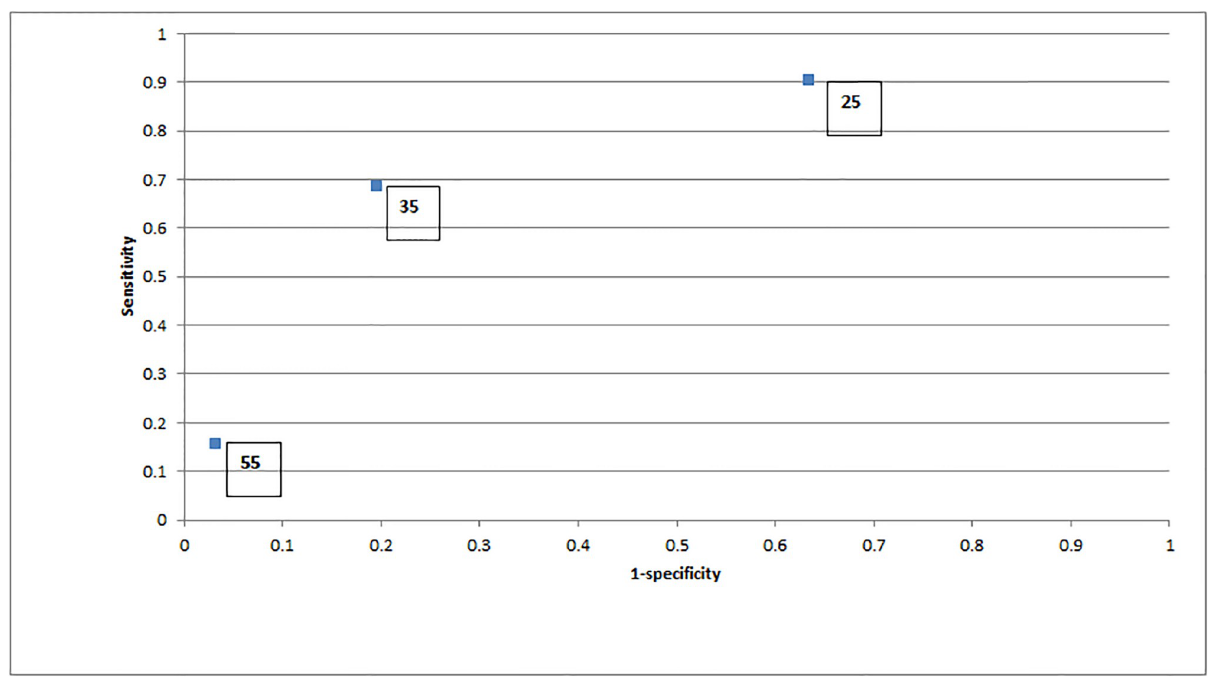
Fig 2. Test performance of Prostate Health Index at cut-off levels of 25, 35 and 55. Figures in boxes are the cut-off levels for the Prostate Health Index test from Chiu et al study [2]. Sensitivity/specificity for any grade cancer at different cut-off levels are 88.7%/36.5% at 25, 61.3%/77.5% at 35 and 12.9%/97.4% at 55.